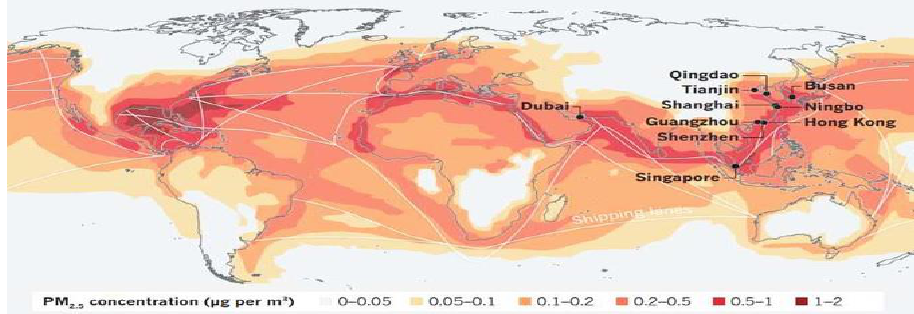
Figure 1. Distribution of the top 10 ports emitting ultra-fine dust worldwide (Wan et al., 2016:275).